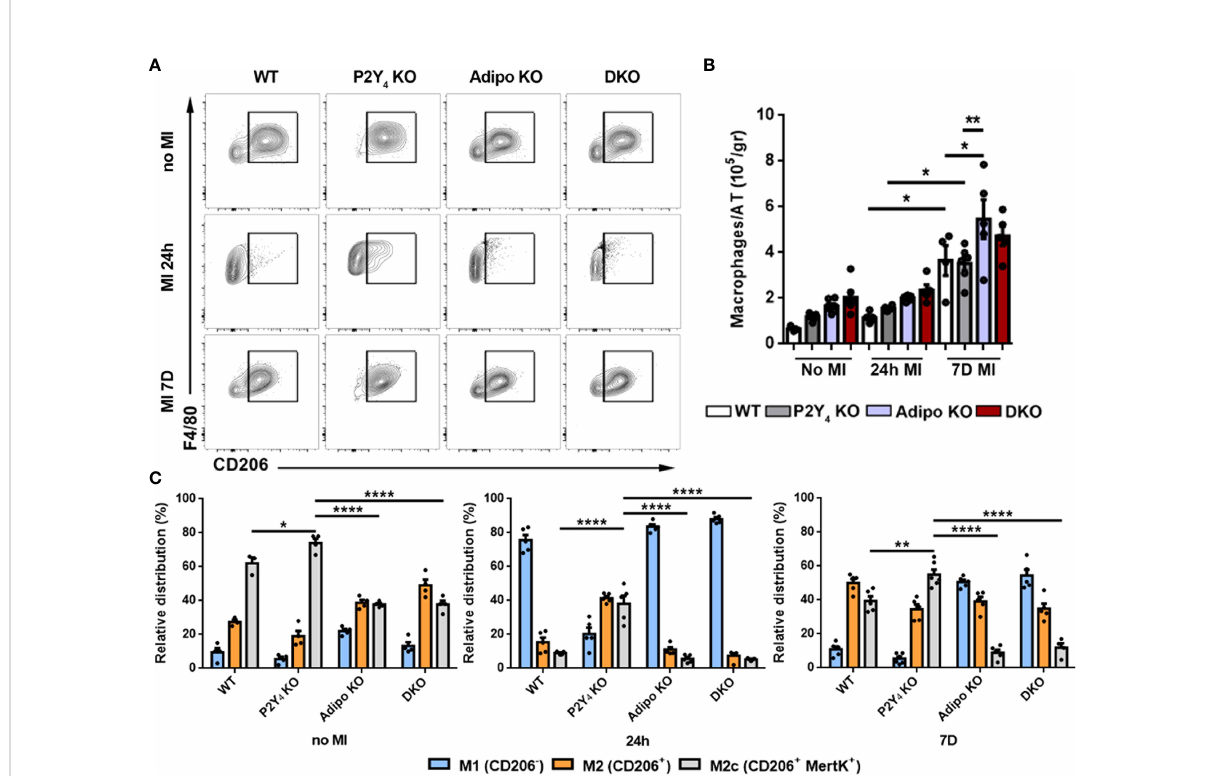
FIGURE 3 Loss of P2Y 4 induces anti-in fl ammatory macrophage polarization in ischemic PAT. (A) Flow cytometry data are shown as representative dotplots for F4/80 and CD206, a marker of M2 macrophages, quanti fi ed in PAT of WT, P2Y 4 KO, adiponectin KO (Adipo KO) and P2Y 4 /adiponectin double KO (DKO) mice, without myocardial infarction (no MI), or 24h or 7 days (7D) after LAD ligation. (B) Histograms representing increase of F4/80 + macrophages after LAD ligation in PAT of WT, P2Y 4 KO, Adipo KO and DKO mice (normalized to adipose tissue (AT) weight) (n = 4-5). (C) Flow cytometry quanti fi cation of M1, M2 and M2c macrophage populations in PAT using CD206 and MertK, a marker of M2c anti- in fl ammatory macrophages. Data are expressed as relative distribution of CD206 - , CD206 + , and CD206 + MertK + macrophage populations within the PAT, before and 24h or 7D after MI (n = 4-6). Data represent mean ± SEM. *p < 0.05; **p < 0.01; ****p <